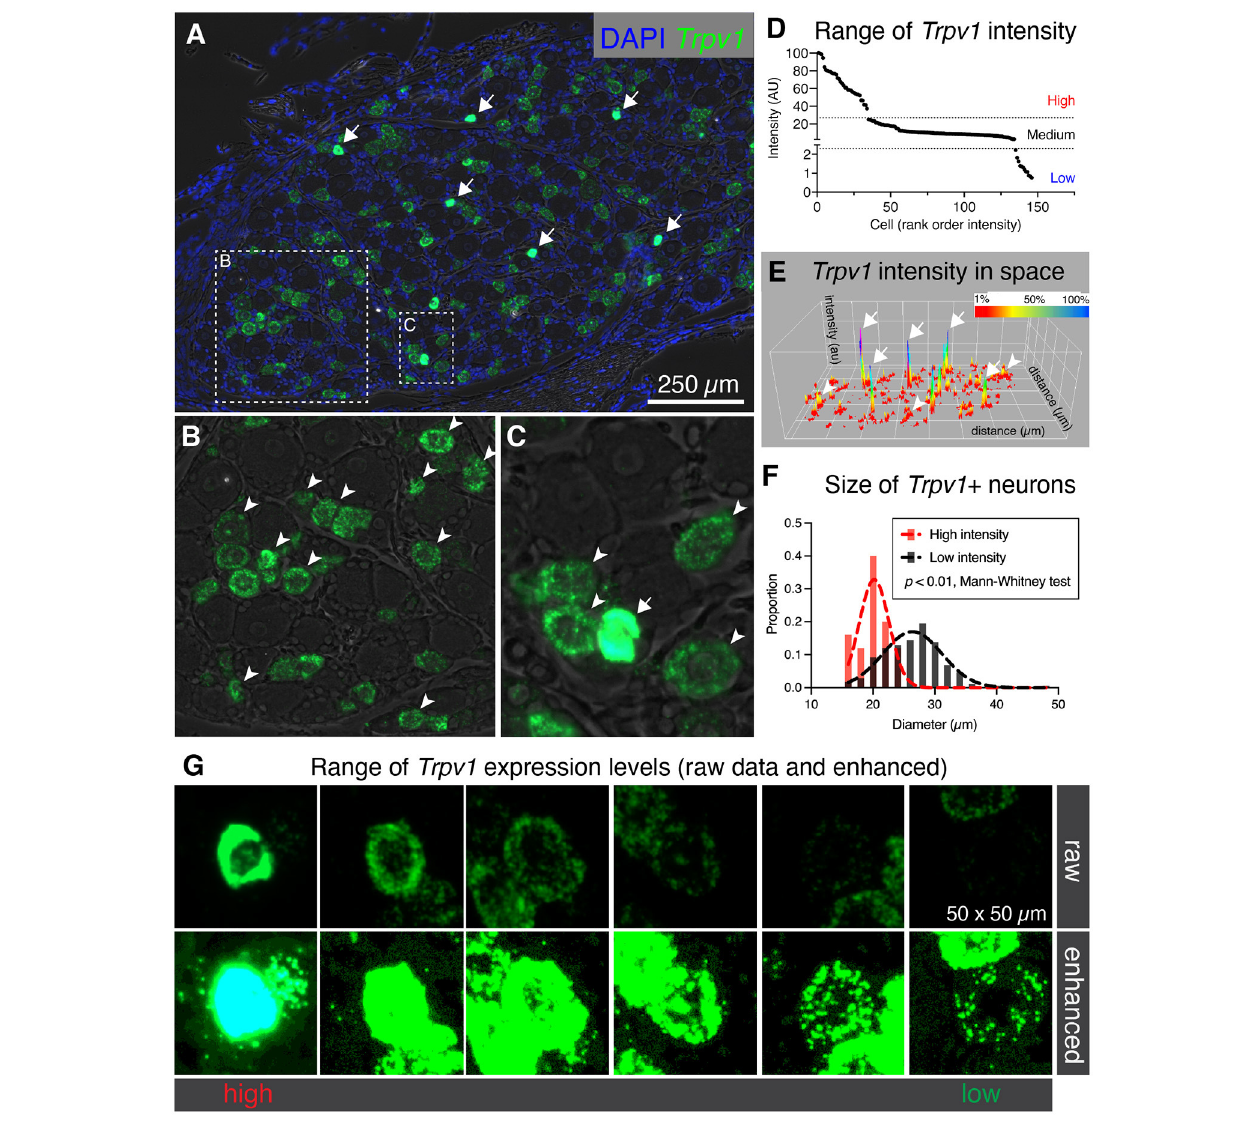
FIGURE 2 | Heterogeneous labeling of Trpv1 mRNA in rat dorsal root ganglion (DRG). (A) Fluorescent in situ hybridization was performed and imaged for whole rat DRG sections ( N 3). Very high levels of expression were observed in a small number of small diameter neurons (white arrows). (B) An enlargement of a neuron-rich = region is shown with Trpv1 neurons (arrowheads). (C) A second enlargement includes one high-expressing Trpv1 neuron (arrow) and several other Trpv1 neurons + + + with moderate staining intensity (arrowheads). (D) Intensity values for Trpv1 were plotted by rank order. Based on these values, Trpv1 expression was divided into high, medium and low expression. (E) A surface plot was generated for Trpv1 intensity (arbitrary units, Z-axis) across the entire DRG section shown in (A) . This plot shows the relationship between the high-expressing Trpv1 DRG neurons and other cells in the ganglion. Note the high peaks indicating a quantitatively separate population (white arrows). (F) Diameter of the high intensity Trpv1 neurons was examined by measuring the area in Fiji. High intensity Trpv1 neurons had a + + stereotyped small diameter as represented by the narrow Gaussian (red) relative to the broader distribution of medium/low Trpv1 neurons (black Gaussian). This + difference was significant based on a Mann-Whitney test ( p < 0.01). (G) Representative fields of 6 Trpv1 DRG neurons are shown, spanning a range of expression + levels. Scanning parameters are tuned so as not to saturate the brightest cells. Note that the range of expression values is such that when the lower expressing Trpv1 neurons are visible, the highest cells are +